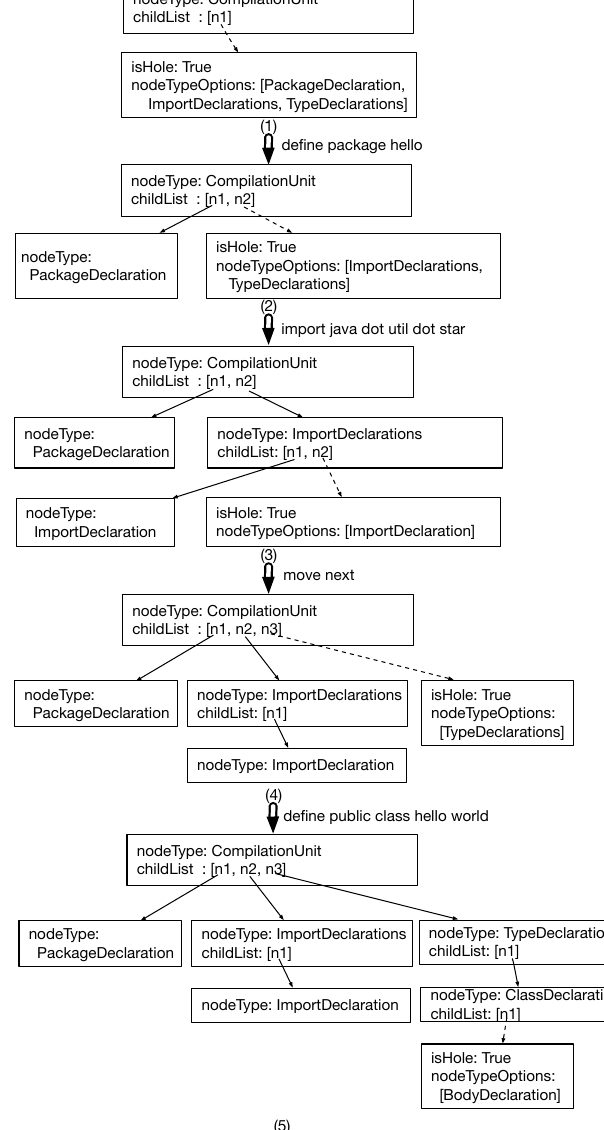
Figure 4. An example of implementation for a VoiceJava